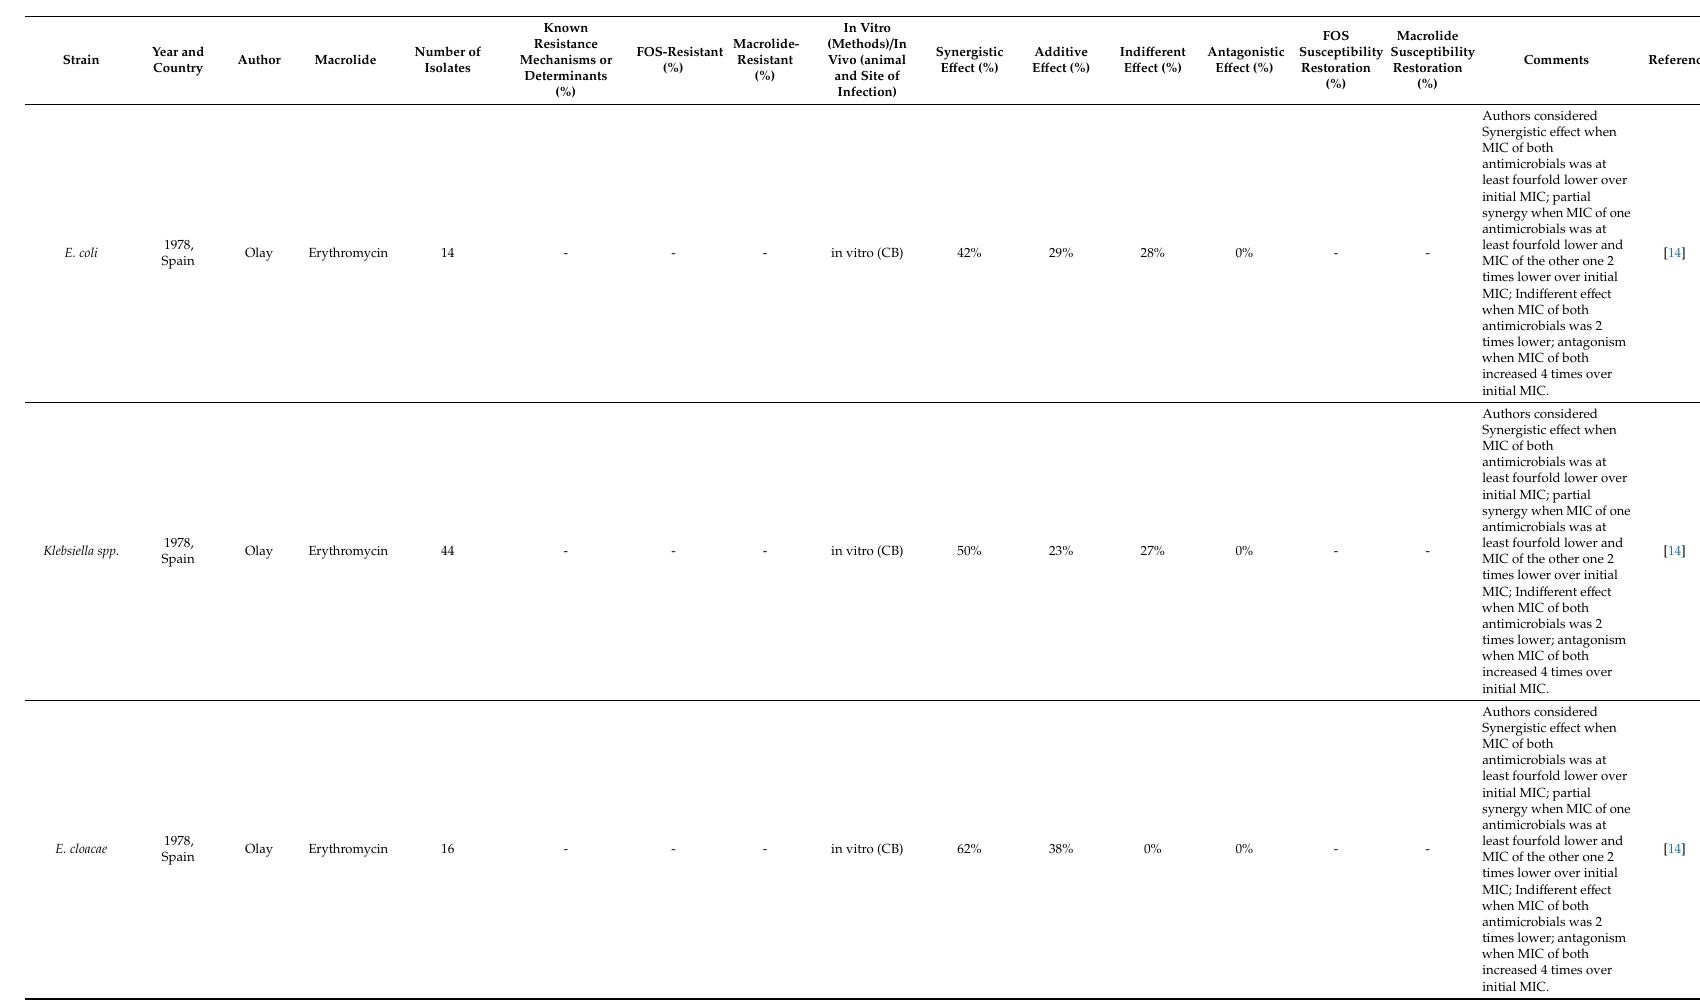
Table 7. Studies on combination between fosfomycin and macrolides. CB: checkerboard assay; TK: time–kill assay; ET: